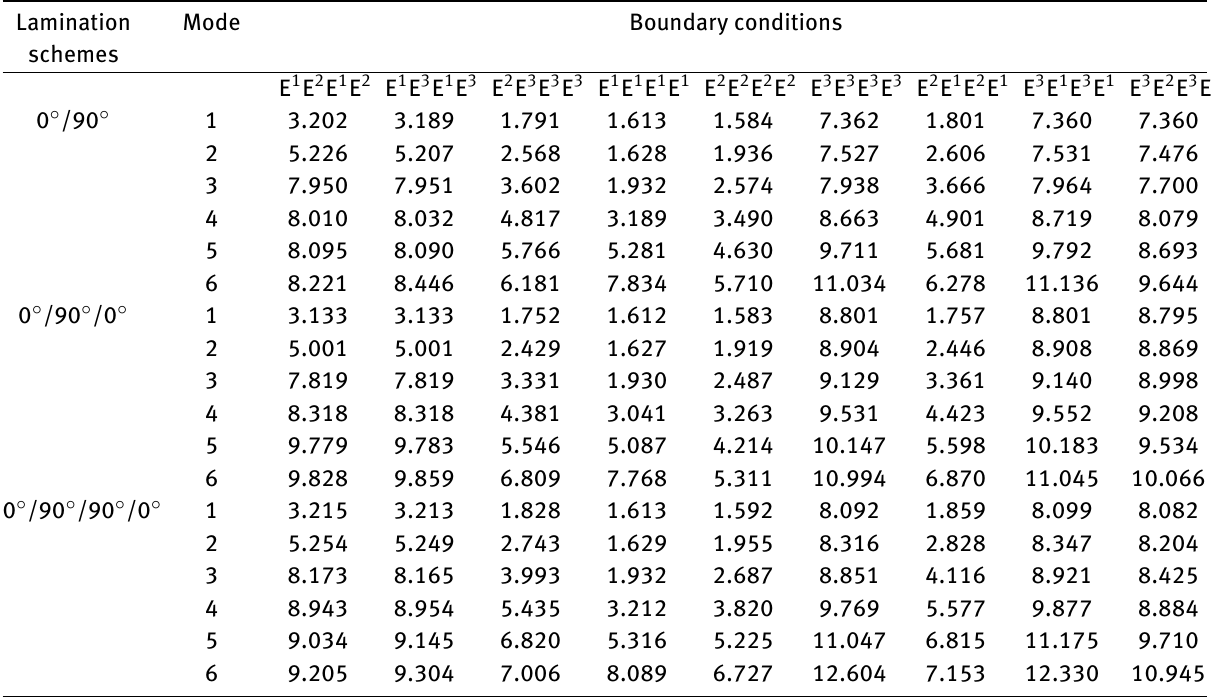
Table 7: Frequency parameters Ω for laminated annular sector plate with different lamination schemes and elastic boundary